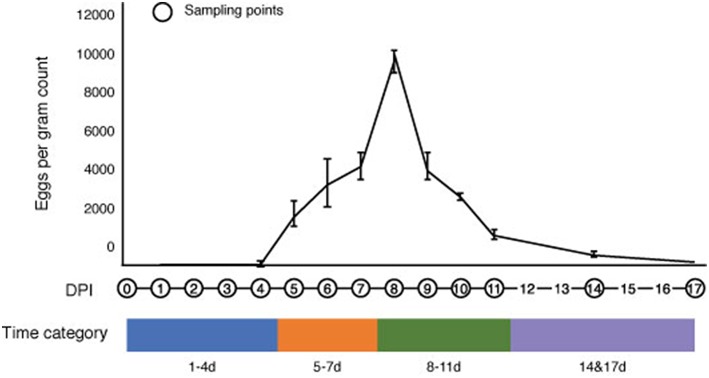
Changes in the number of Strongyloides venezuelensis eggs per gram of feces during the progression of infection. S. venezuelensis eggs were first detected at 5 days post-infection (DPI), with peak numbers being observed at 8 DPI. The infection period was divided into four categories: 1–4 DPI (blue), 5–7 DPI (orange), 8–11 DPI (green) and 14 and 17 DPI (purple).